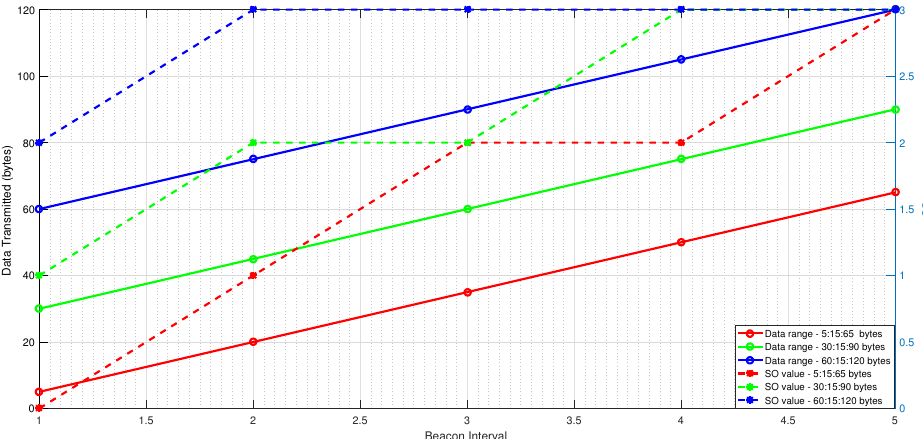
Figure 5. ESS ADC adjusting its SO against transmitted